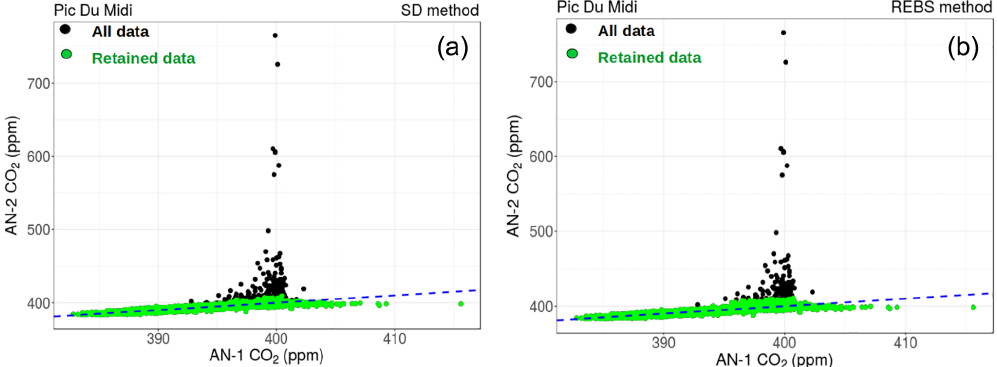
Figure 6. Plots of CO 2 measurements of AN-1 against AN-2. All data are in black, and the green points represent the retained data using SD method for (a) and REBS method for (b)